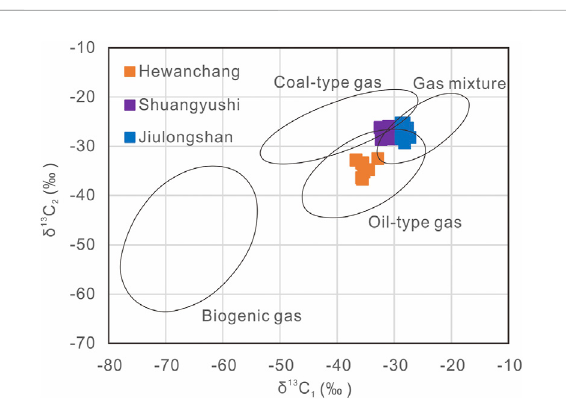
FIGURE 4 Cross-plot of δ 13 C 1 vs. δ 13 C 2 for natural gas samples from different areas to indicate the genetic types and origins of natural gas. The genetic types of natural gas are described in Liu et al.,